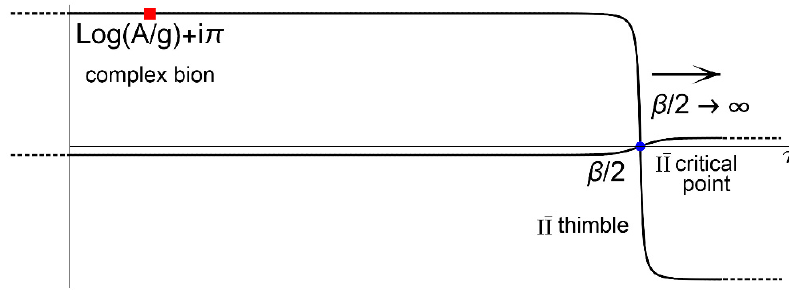
Figure 3 . Plot of the Lefschetz thimble attached to the [ I (cid:22) I ] critical point at (cid:28) the critical point moves to in(cid:12)nity and its contribution to the thimble integral vanishes. However, the integral receives a non-vanishing contribution from a complex bion con(cid:12)guration located at = log( A=g ) + i(cid:25) . Compare with (cid:12)gure 2. (cid:28) (cid:3) + The QZM direction is non-Gaussian, and this fact is encoded in the thimble integration. The contour should be deformed along the downward (cid:13)ow direction, as in (cid:12)gure 1. Then the exact integration over the quasi-zero mode thimble (cid:0) (cid:18) =0 (cid:6)